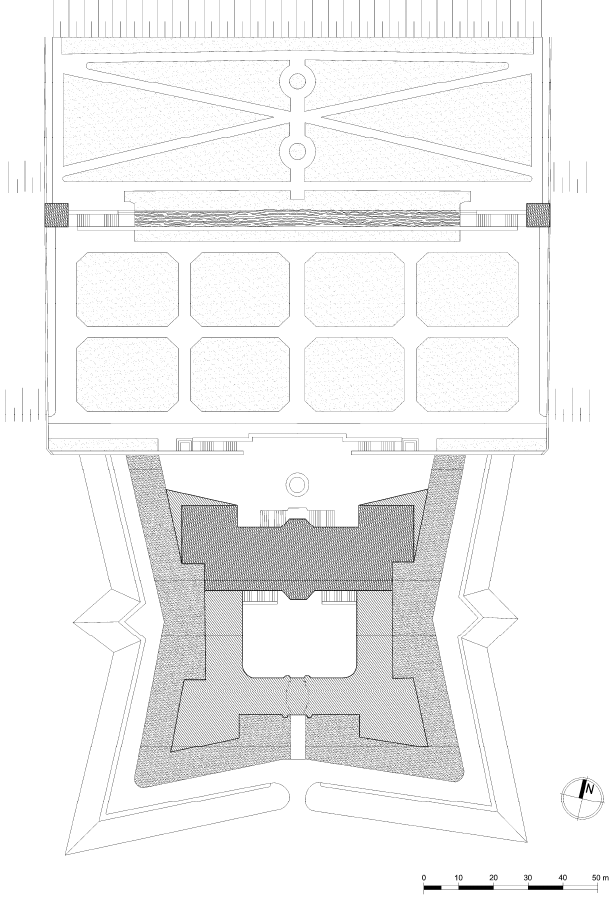
Figure 19. Podhorce: Koniecpolscy’s residence—palace plan with fortifications; created by authors.